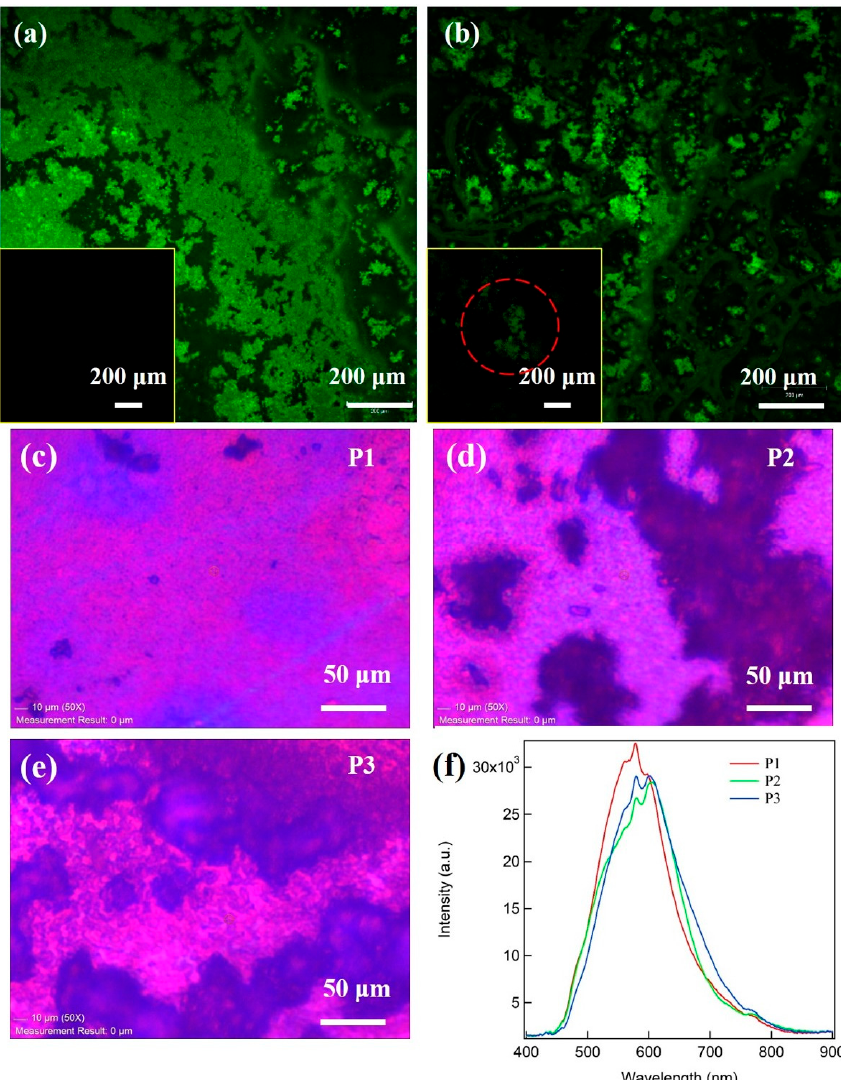
Figure 5. The CLSM images of ( a ) BIQ/SiO 2 and ( b ) BIQ/ZnO NRs samples. The PL receiving wavelength range is from 510 to 810 nm. The subfigure in ( a , b ) corresponds to the CLSM image when receiving the PL wavelength with a range of 350–510 nm. The PL image of BIQ/ZnO NRs sample when ( c ) P1, ( d ) P2, and ( e ) P3 are in different positions. ( f ) The corresponding PL emission spectrum at P1–P3.